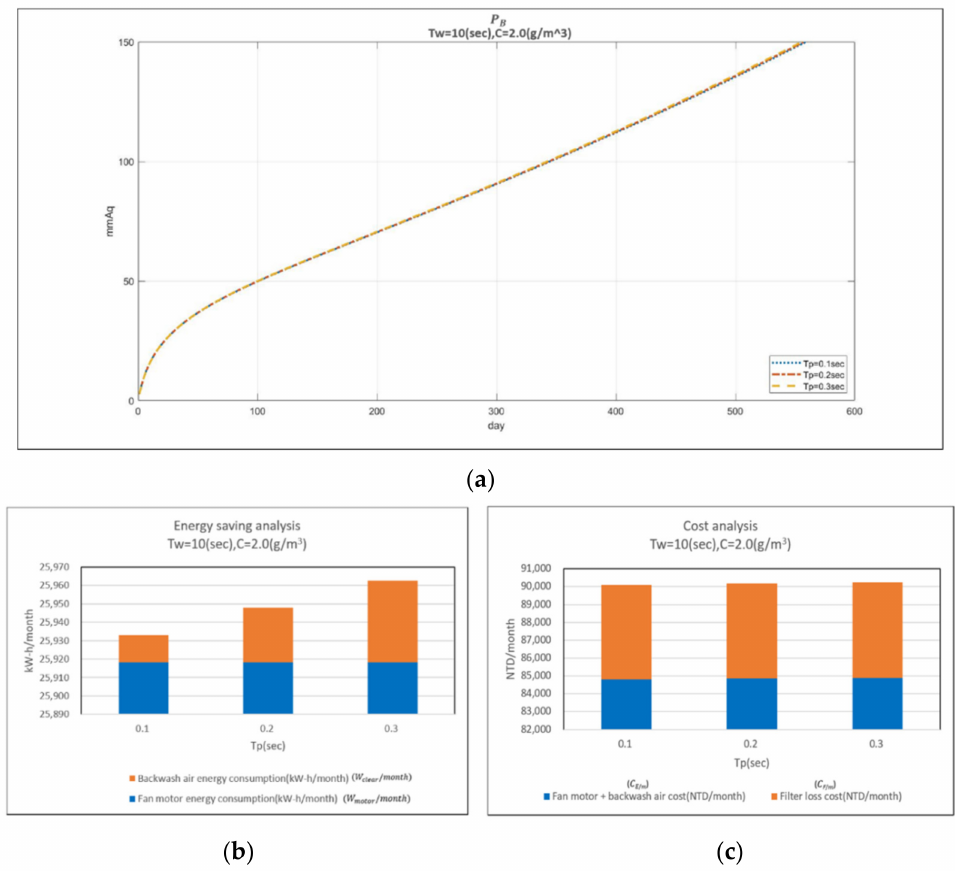
Figure 9. The simulation of energy consumption on different pulse times. ( a ). The analysis of the pressure drop. ( b ). The analysis of energy saving. ( c ). The analysis of